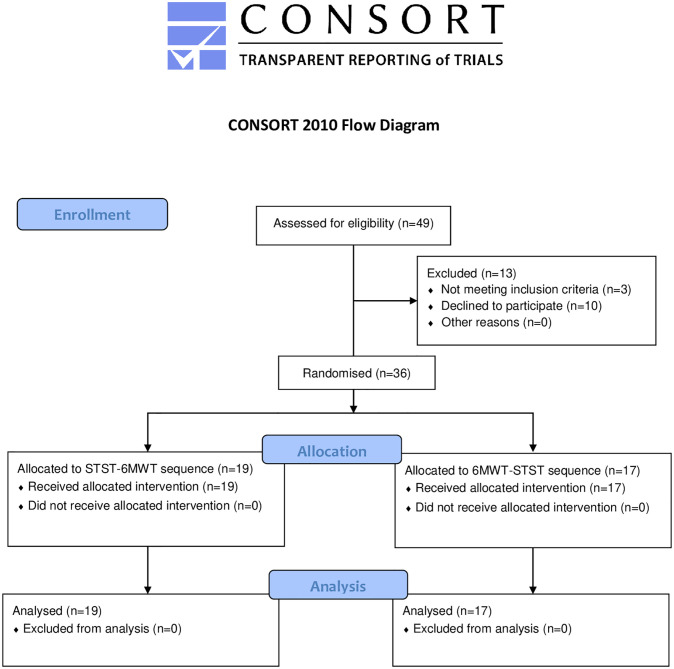
Flow diagram illustrating patient participation (CONSORT).